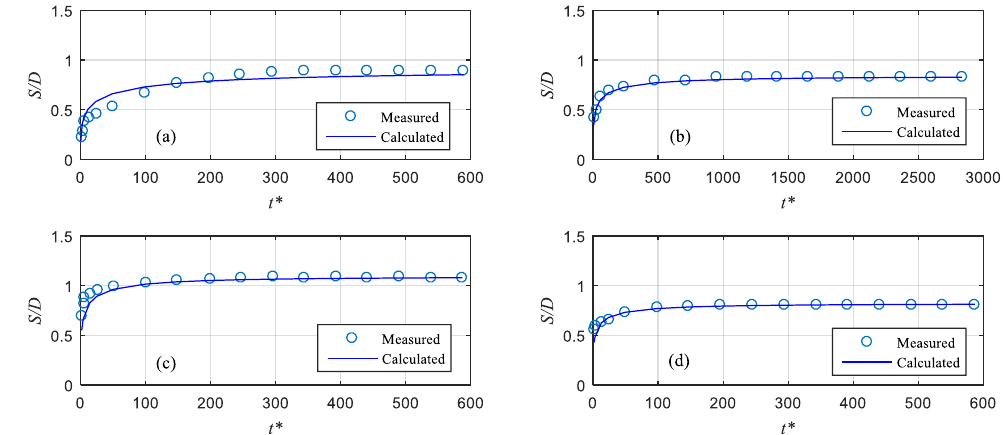
(2006) [40]; ( h – j ) Alabi (2006) [39]. Water 2020 , 12 , x FOR PEER REVIEW [40]; ( h – j ) Alabi (2006) [39].